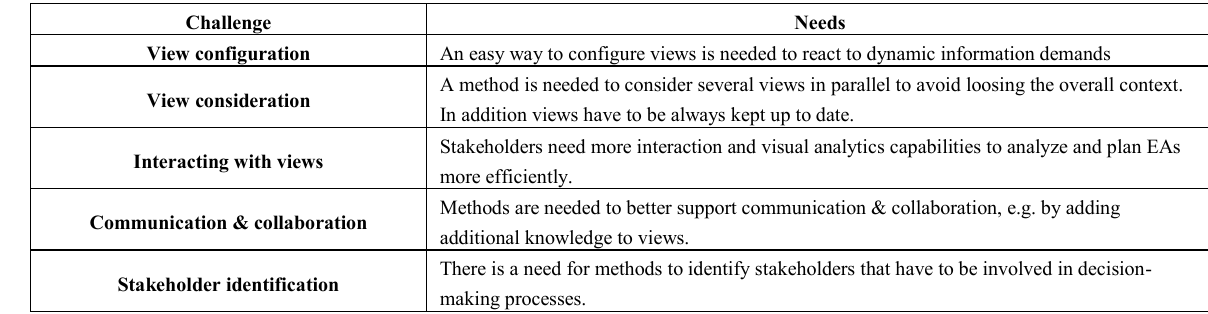
Table 3. Challenges and needs in decision-making